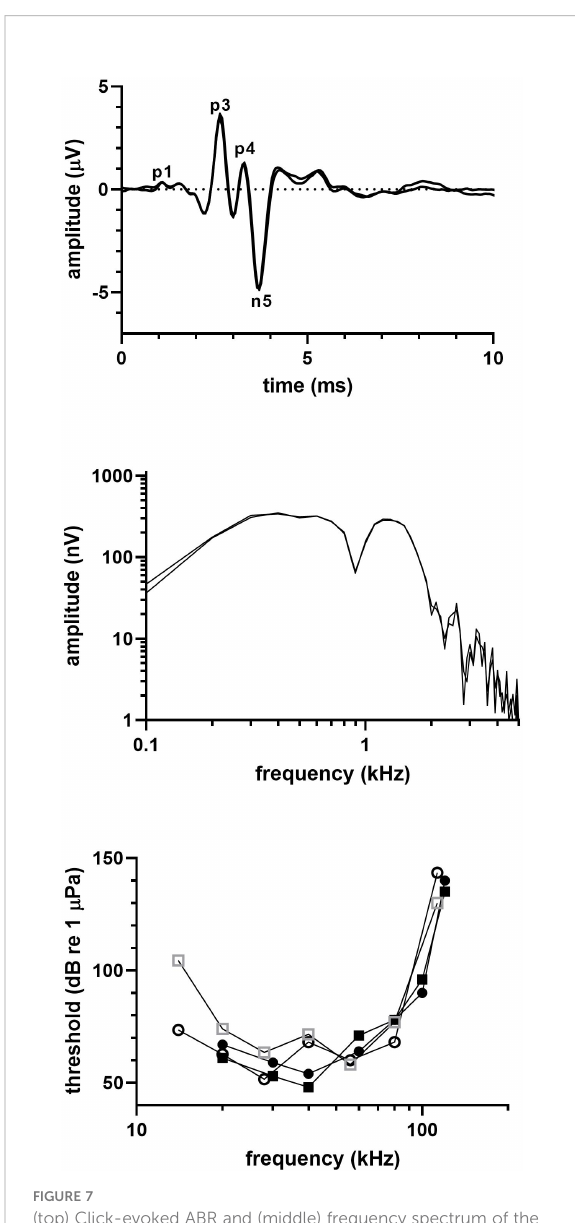
FIGURE 7 (top) Click-evoked ABR and (middle) frequency spectrum of the ABR waveform for a pygmy killer whale. (bottom) Audiograms for the two pygmy killer whales tested in this study (open square=30IMMS, open circle=31IMMS), as well as the audiograms of two pygmy killer whales previously tested ( fi lled symbols; Montie et al.,